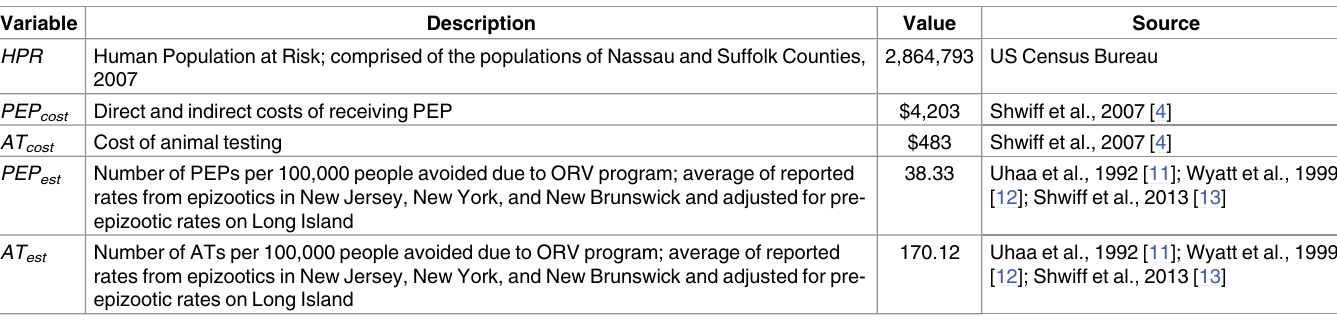
Table 2. Values and sources of variables in Eq